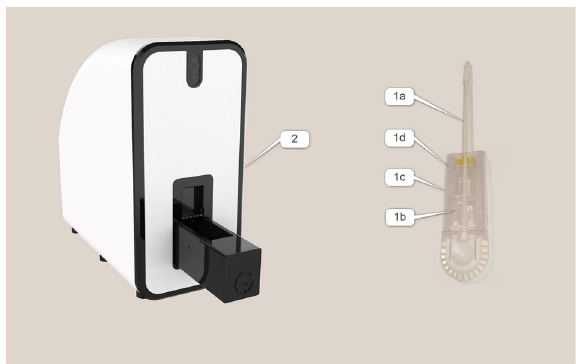
Fig. 4 The Gyni investigational test system components. Actual hardware components of the disposable discharge collection tool and the tabletop scanner.